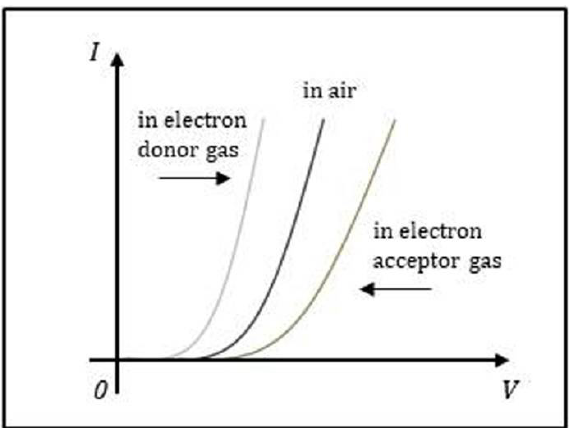
Figure 5. Schematic illustration of the I−V characteristics for a graphene/ n -type Si Schottky diode sensor in air, exposed to electron-donor gas and electron-acceptor gas.